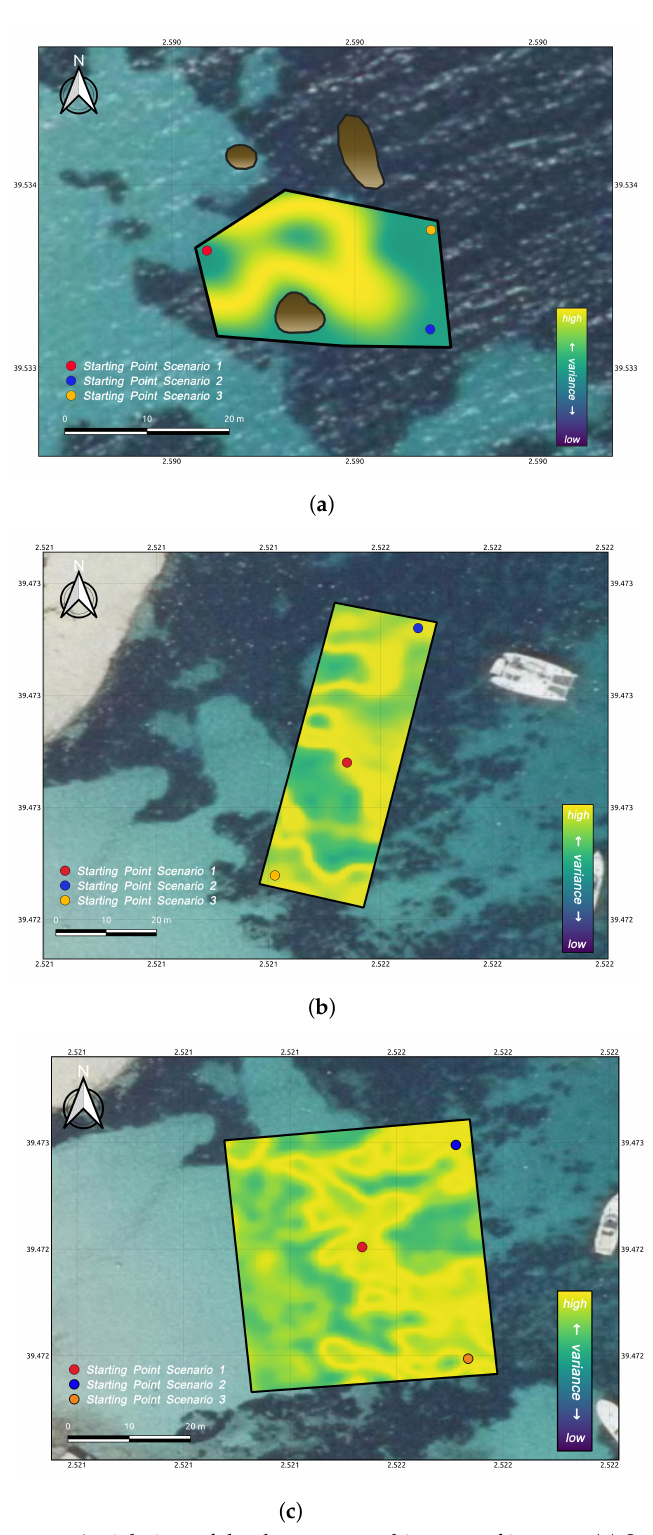
Figure 4. Aerial view of the three geographic areas of interest. ( a ) Starting points Area 1; ( b ) Starting points Area 2; ( c ) Starting points Area